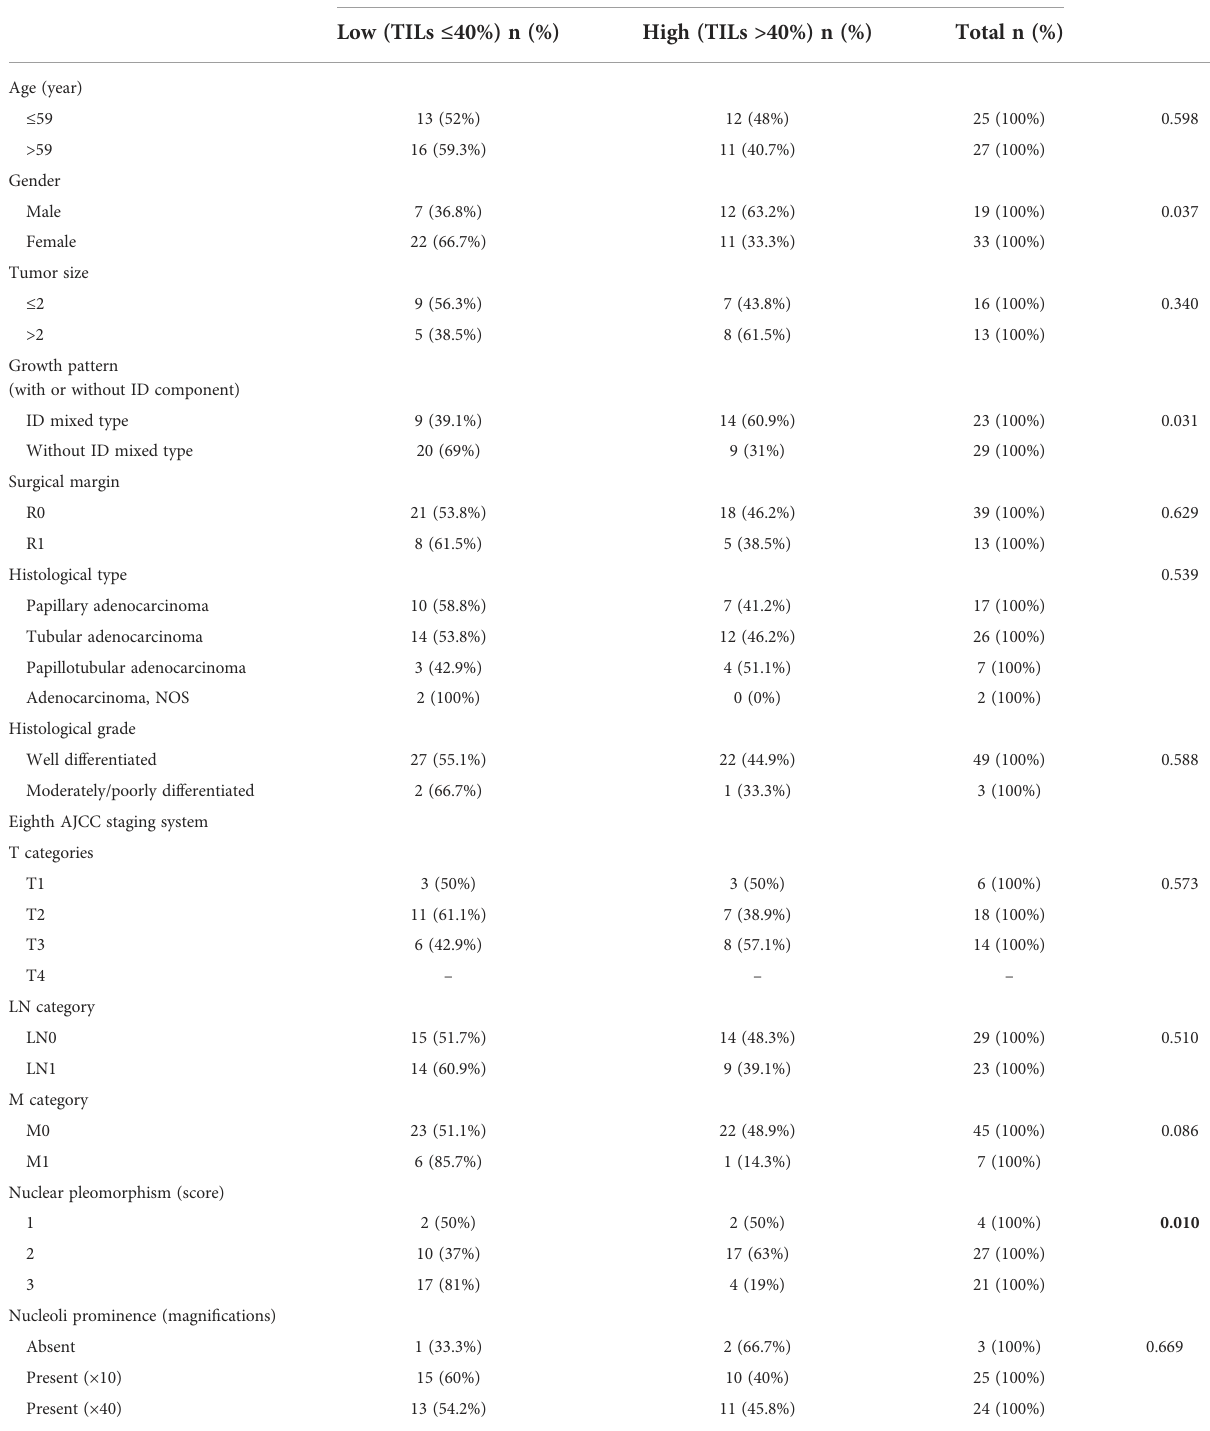
TABLE 2 Correlation between the TIL level and clinicopathological features in patients with distal